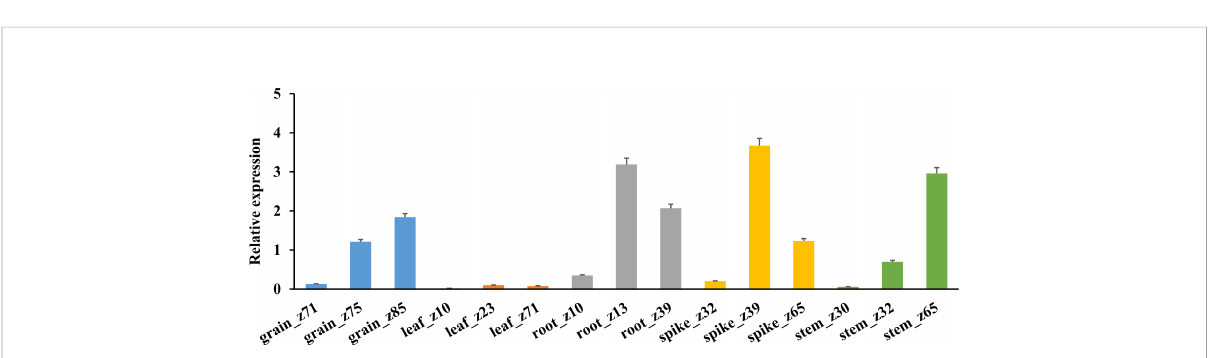
FIGURE 3 TaHAK13 expression in different tissues. An RNA-seq analysis of wheat expression data was used to assess the expression speci fi city of TaHAK13 in different tissues.